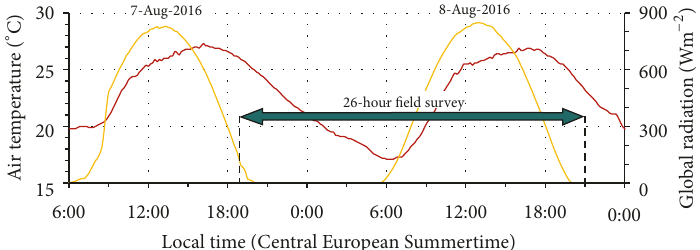
Figure 4: Background weather parameters (yellow: global radiation, red: air temperature) during the field measurements (10-min average data were obtained from the inner-city weather station of Szeged, 0.9 km away from the survey